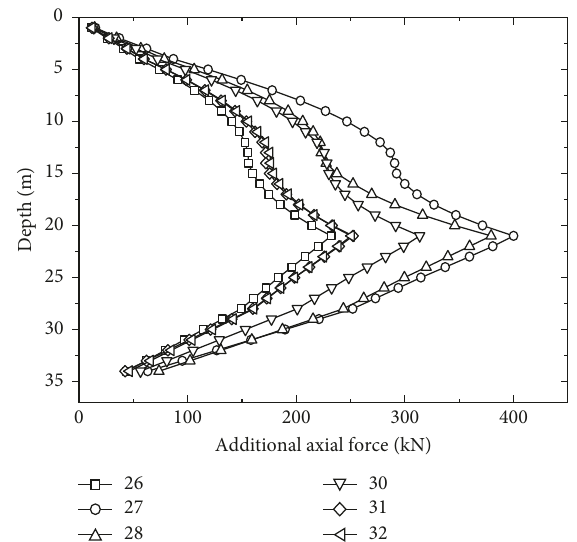
Figure 14: Comparison of theoretical and measured settlement values of Wulin Road excavation. Figure 15: Additional axial force distribution of loaded pile of Wulin Road